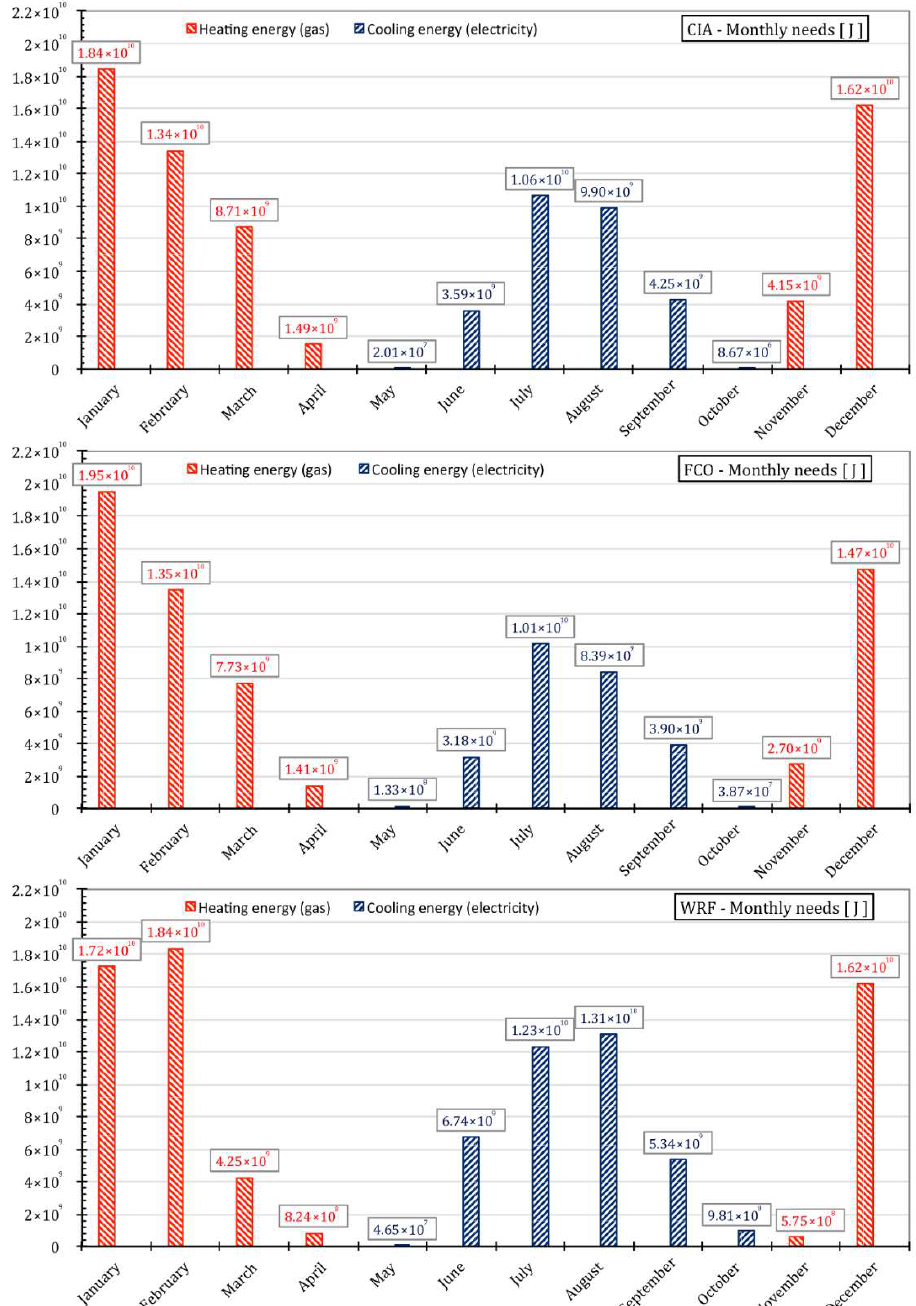
Figure 8. Monthly energy needs of primary energy (gas for heating and electricity for cooling; J) of the system “building envelope/plants” in the case study analyzed for different climate databases used.